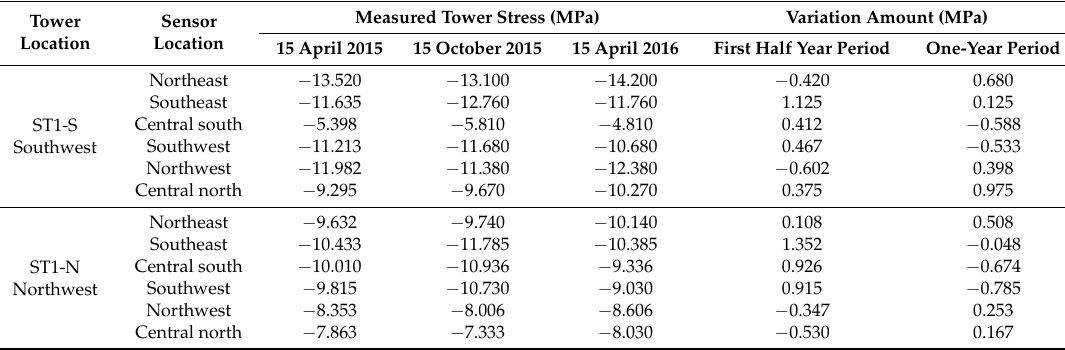
Table 5. Measured tower root stress and variation